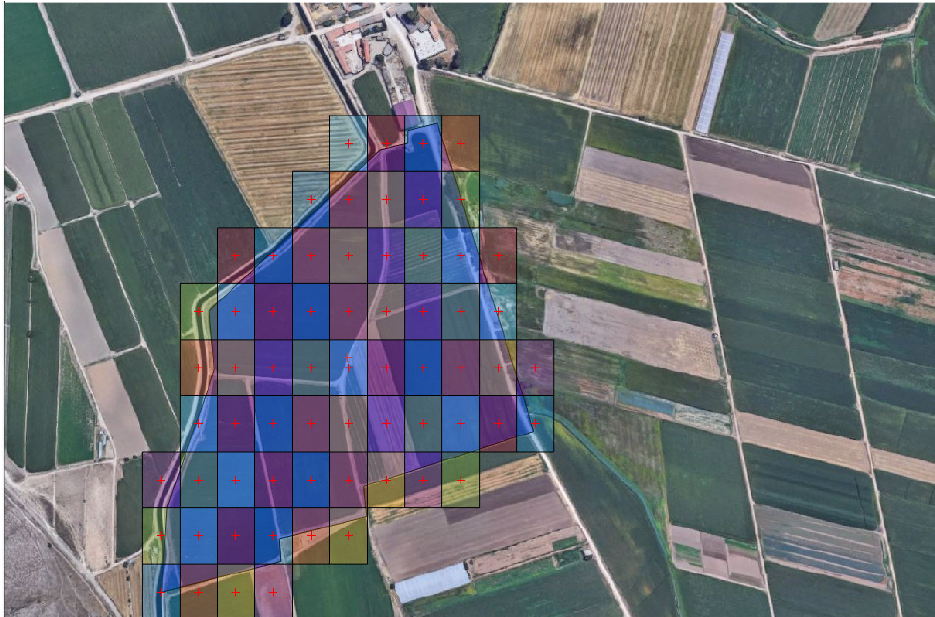
Figure 6. Waypoints obtained from a tessellation process without overlap between tiles. Route starts from the bottom to the top and from the left to the right.